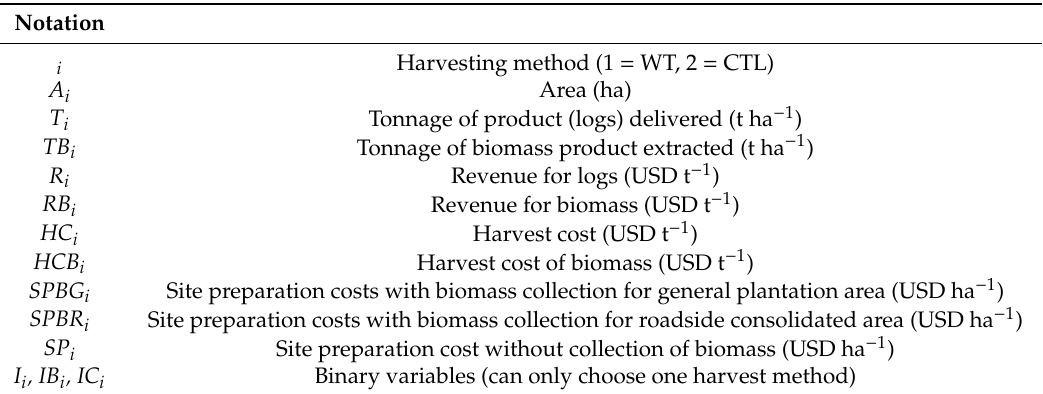
Table 1. Optimization model